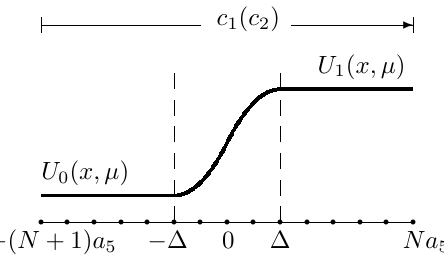
Figure 2 . Domain wall fermion with a (cid:12)ve-dimensional link (cid:12)eld interpolating U 0 ( x; (cid:22) ) and U 1 ( x; (cid:22) ).